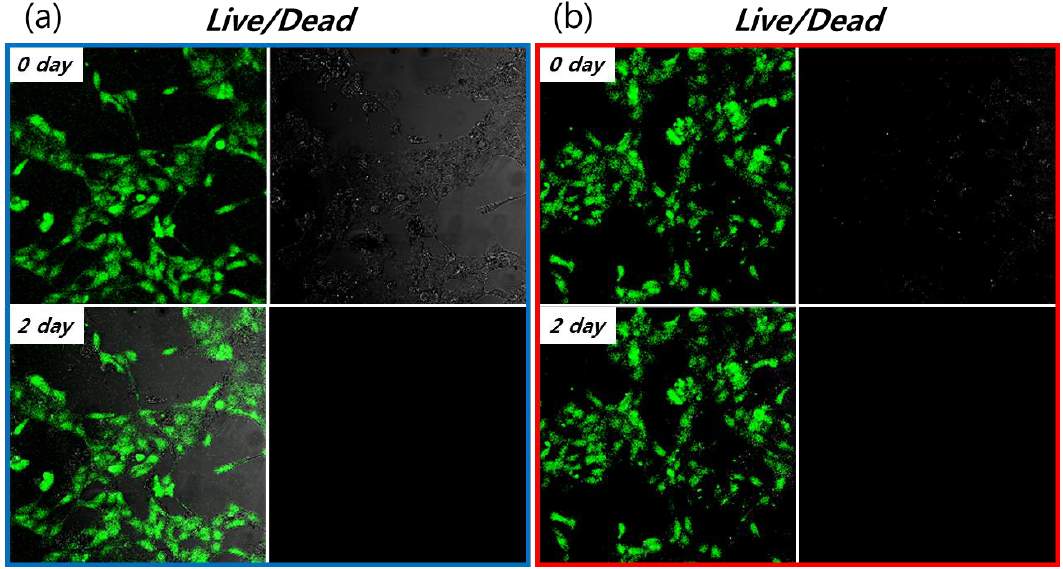
Figure 8. Live/dead confocal microscopy image of acrylic PSA films using calcein AM and propidium iodide: ( a ) Acryl-6, hydrophilic, and ( b ) Acryl-40, hydrophobic (live cell, green; dead cell, red).